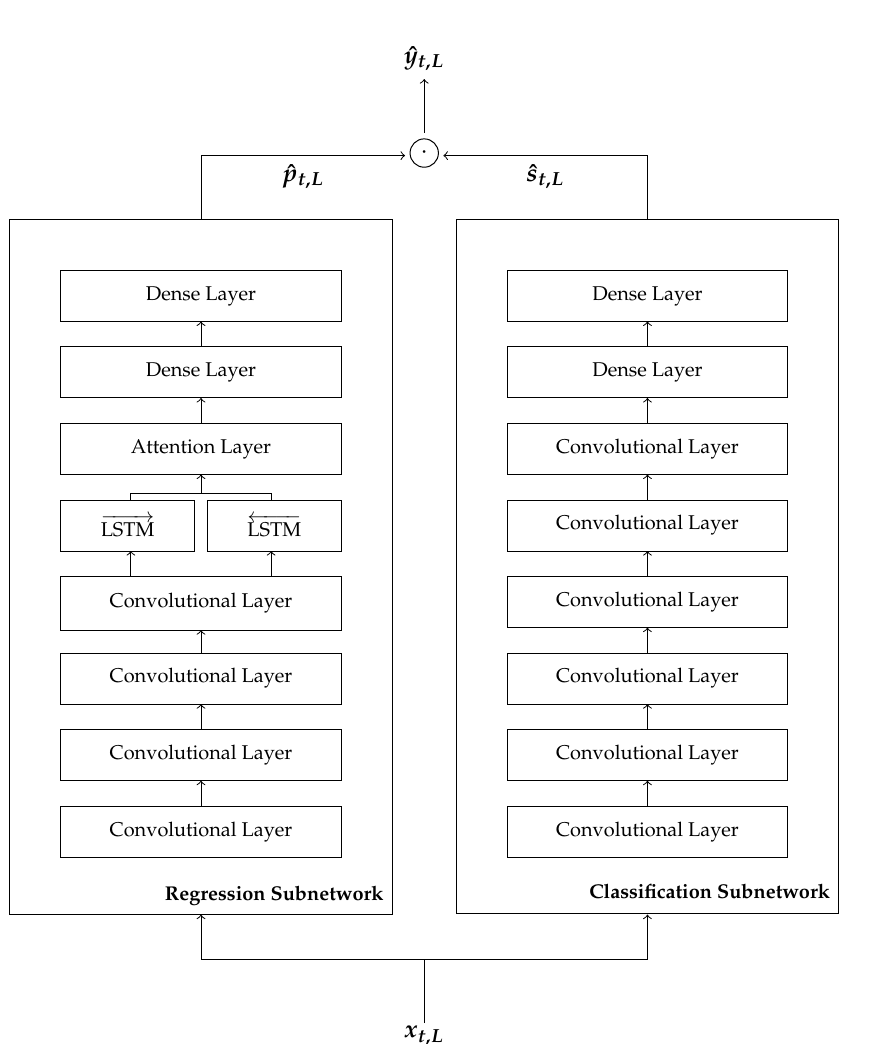
Figure 3. Proposed Load Disaggregation with Attention (LDwA) architecture used in our experi-